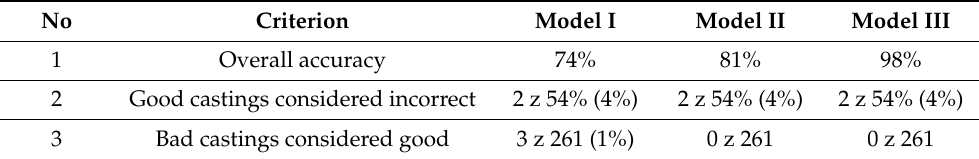
Table 6. Summary of model Table 6 . Summary of model characteristics .